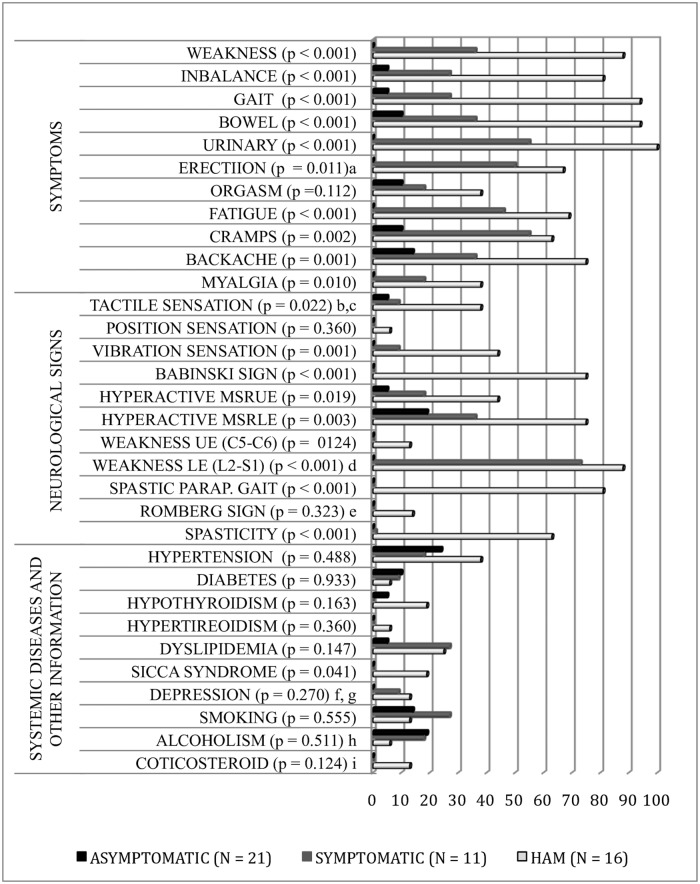
Percentages of symptoms and neurological signs, systemic diseases and social habits by group of HTLV-1 infected.MSRUE—Muscle stretch reflexes of the upper extremities; MSRLE—Muscle stretch reflexes of the lower extremities; MSR—Muscle stretch reflexes; UE—upper extremities; LE—lower extremities; aConsidered men only; bSensory changes due to leprosy sequel (AG); cHypoaesthesia below T1 with normal MRI (SG). It evolved with spontaneous clinical improvement; dMuscle weakness compromised the myotomes in the following proportion: L2 (88%), L4-L5 (38%), S1 (25%) and L3 (13%) in HG and L2 (73%) in SG; eIt was not evaluated in 2 restricted individuals the wheelchair (HG); fThe prevalence of depression may be underestimated. Participants of the GIPH cohort with uncontrolled psychiatric illness and high doses of psychotropic medications were not invited for this study. gGeriatric Depression Scale– 15 itens (GDS -15), hWHO (>15 doses/week-men and >10 doses/week-women), dose—8 a 13 g of ethanol; I0.25 e 0.75 mg dexamethasone/day. AG = Asymptomatic Group, SG = Symptomatic Group, HG = HAM/TSP, CG = Control Group.